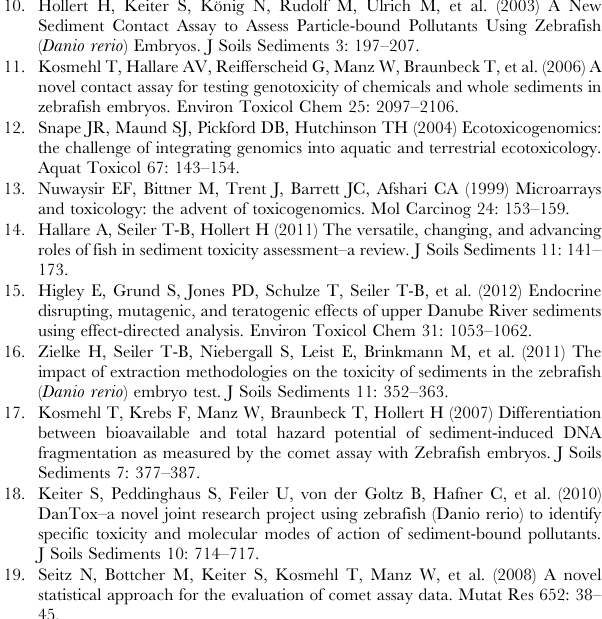
Figure S1 Profiles of gene expression levels of extracts from Danube River sediments compared to sediment extracts from the river Rhine. The profile of a process control is also presented. The highlighted set of genes includes down-regulated genes encoding proteins associated with digestion or fatty acid metabolism and hydrolase activity. Several of these genes were similarly regulated after treatment with extracts regardless of the sampling locations. Table S1 Significant alterations in the expression level of mRNAs with a fold-change $ 2 and an adjusted p-value # 0.025 for whole sediment and sediment extract treatments. Fold changes are listed for the corresponding gene names. A (green background) marks genes encoding proteins mainly with hydrolase activity. B (purple background) marks genes encoding enzymes related to xenobiotic metabolism. C (red background) marks genes encoding proteins related to DNA damage response or to DNA/mRNA binding. Investigated were whole sediments and sediment extracts from the sampling sites Sigmaringen (Sig), Ehingen (Ehi) as well as the tributary Lauchert (Lau) along the Danube River in